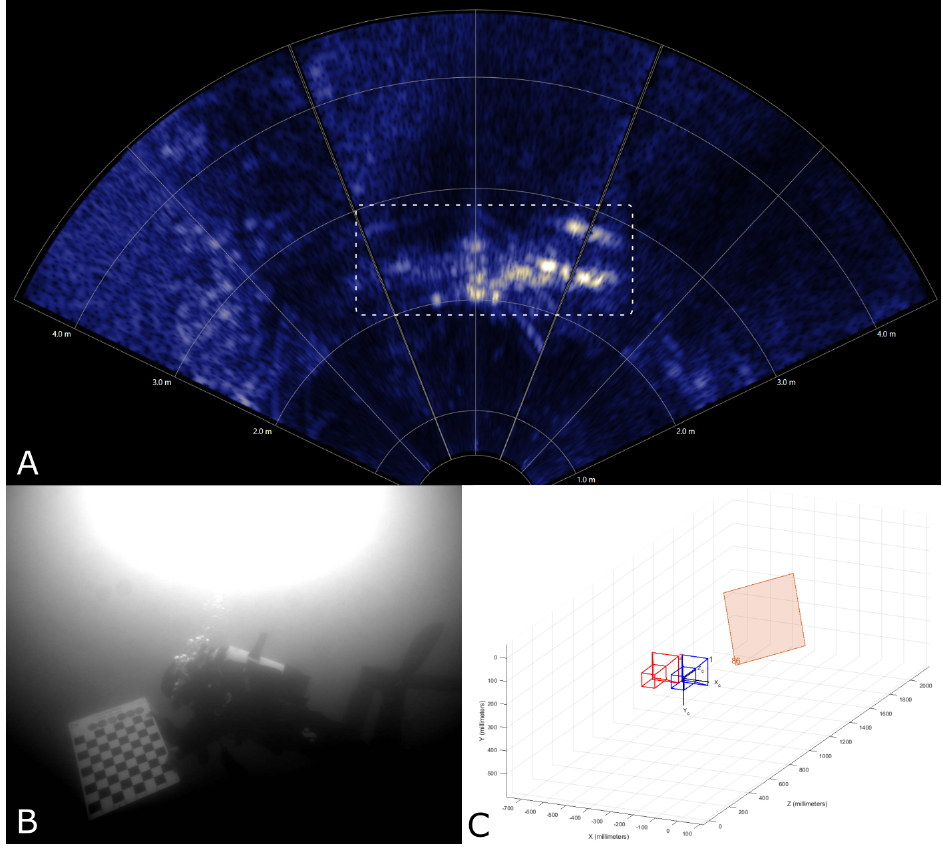
Figure 5. To validate the stereoscopic measurements, the synchronized sonar data were used. Here, the sonar ( A ) measures the distance of a diver holding a calibration target (marked with a white rectangle) at ∼ 2 m. Using the camera data ( B ), the second camera view has been omitted here, the 3D position of the same calibration target, relative to the two cameras (represented here in red and blue), has been estimated at a distance of ∼ 2 m as well ( C